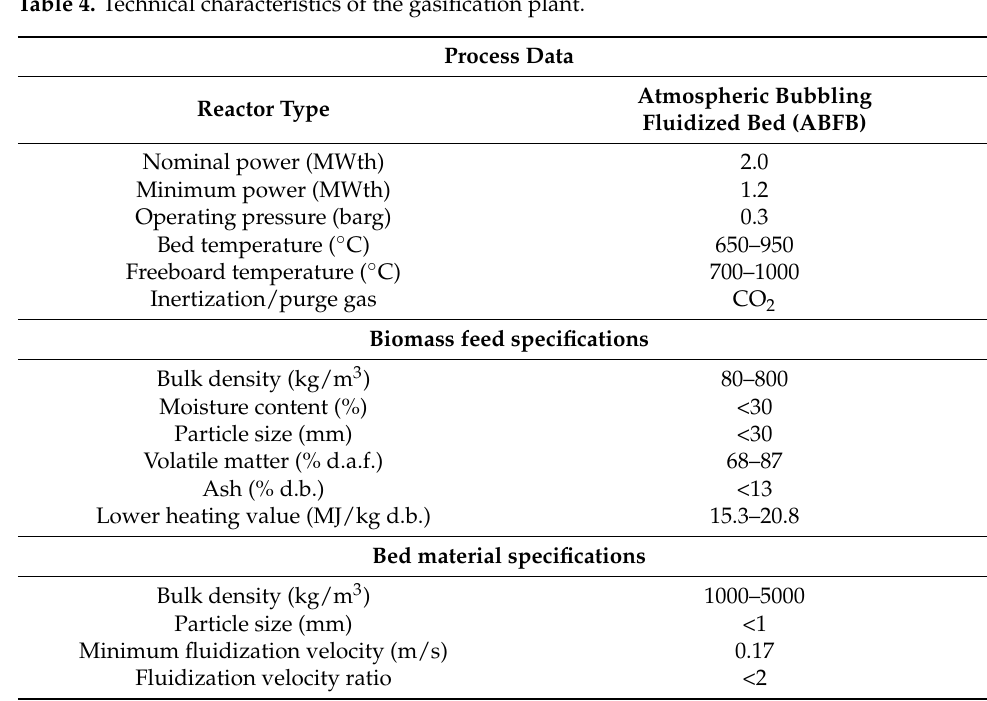
Figure 5. Location of the gasification plant. Table 4. Technical characteristics of the gasification